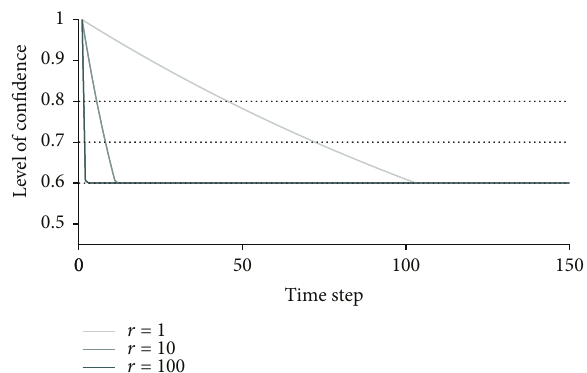
Figure 9: Manipulation of con fi dence C change over time: C drops 20, 30, or 40%, with the slope of decline determined by the parameter r of the exponential function f x = e − rx ; the higher r , the steeper the slope of C decline. Time step refers to discrete simulation time where each step iterates a de fi ned set of actions (see Appendix B). Note: the observed time horizon is extended from 100 to 150 time steps, as additional time steps were needed for the system to reach the steady state when the slope of C decline was low ( r = 1